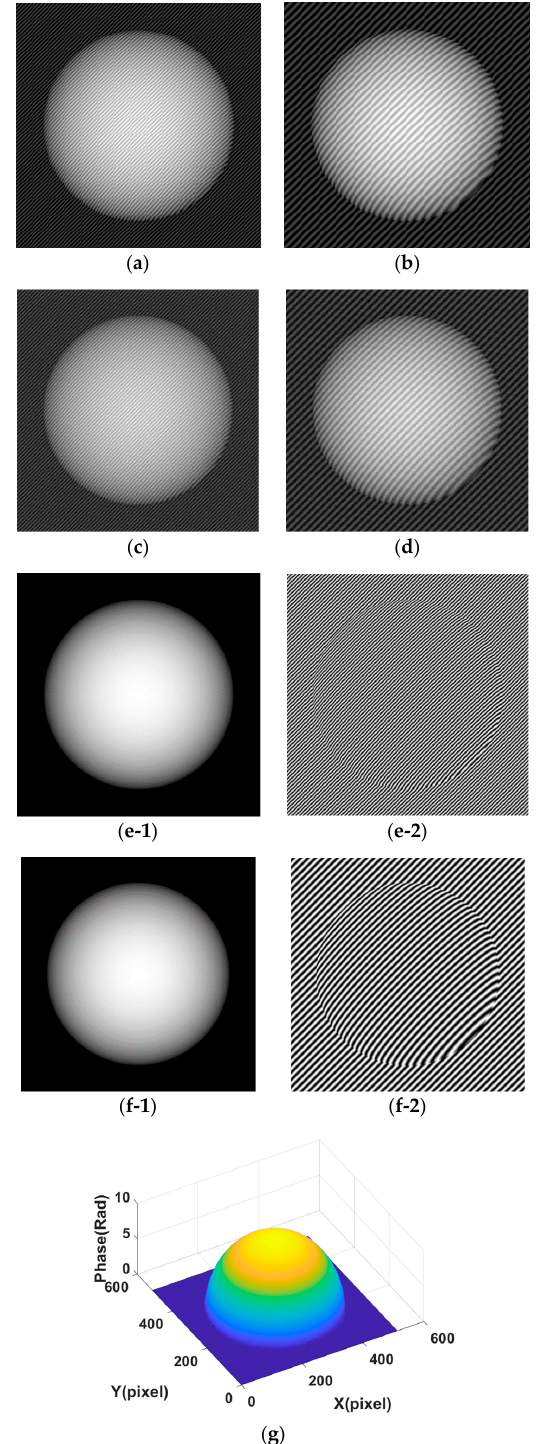
Figure 1. Simulated projection fringe patterns of sphere shape. ( a ) Fringe pattern with frequency 1/8 without noise added; ( b ) Fringe pattern with frequency 1/16 without noise added; ( c ) Fringe pattern with frequency 1/8 with Gaussian noise added; ( d ) Fringe pattern with frequency 1/16 with Gaussian noise added; ( e-1 ) The ground truth background part of Figure 1a,c; ( e-2 ) The ground truth fringe part of Figure 1a,c; ( f-1 ) The ground truth background part of Figure 1b,d; ( f-2 ) The ground truth fringe part of Figure 1b,d; ( g ) The ground truth